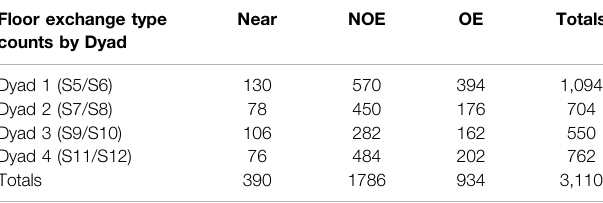
TABLE 2 | Summary of fl oor exchange type counts by